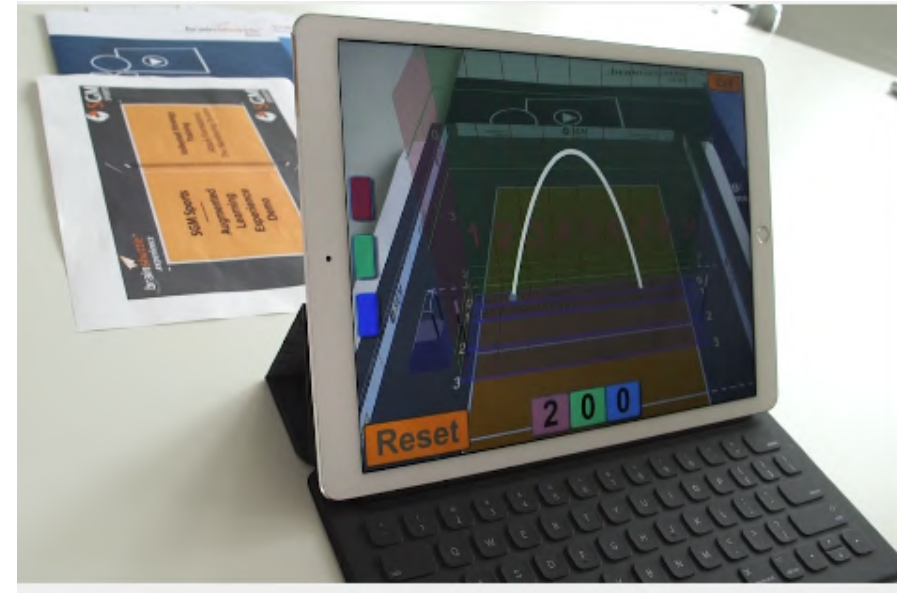
Figure 1: Organizing specialized online training using SGM SPORTS